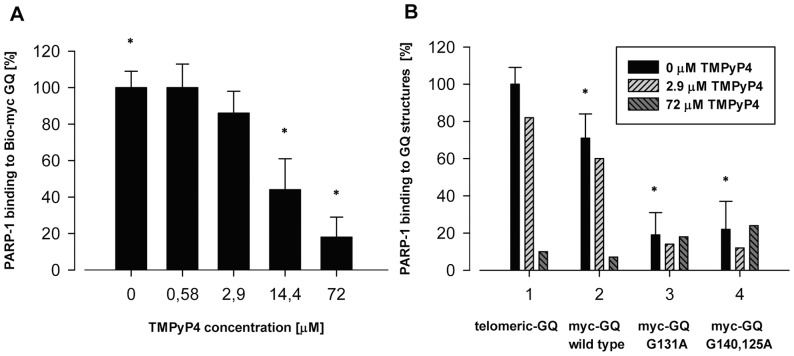

In vitro binding of h PARP-1 to the h c-myc GQ structure and the effect of TMPyP4 on that binding.
Figure 1A Effect of TMPyP4 on the binding of PARP-1 to the c-myc GQ structure. 0.45 pmol aliquots of h PARP-1 were incubated with 5 pmols of 5′-biotine end-labeled wild type h c-myc GQ oligonucleotide (wild type GQ, 5′-biotin-TGG GGA GGG TGG GGA GGG TGG GGA AGG) in the absence and in the presence of different concentrations of the cationic porphyrin compound TMPyP4 as described in the Materials and Methods. Binding is expressed as % of binding measured in the absence of competing TMPyP4 and is shown on the ordinate. TMPyP4 concentrations (0, 0.58, 2.9, 14.4, and 72 µM) are shown on the abscissa. Asterisks represent samples where the extent of binding are significantly different (p<0.05, Student t-test). Figure 1B
In vitro binding of h PARP-1 to various GQ structures and the competing effect of TMPyP4 on that binding. 0.45 pmol aliquots of h PARP-1 were incubated either with 5 pmols h telomeric GQ structure (h-telomeric GQ, 5′-biotin-TTA GGG TTA GGG TTA GGG TTA GGG) or with wild type c-myc GQ structure (wild type GQ, 5′-biotin-TGG GGA GGG TGG GGA GGG TGG GGA AGG) or its mutants (mutant-1 GQ, 5′-biotin-TGG GGA GGG TGA GGA GGG TGG GGA AGG, mutant-2 GQ, 5′-biotin-TGA GGA GGG TGG GGA GAG TGG GGA AGG). The sites of mutations are shown in bold. Binding assay was carried out as described in Materials and Methods. Ordinate shows the binding of PARP-1 to GQ structures (telomeric GQ, c-myc GQ, G-131A and G-140, -126A) expressed in percentage. The amount of PARP-1 bound to telomeric GQ is taken as 100%. Insert shows the applied concentrations of TMPyP4. Asterisks represent samples where the difference in binding is significantly different (p<0.05).